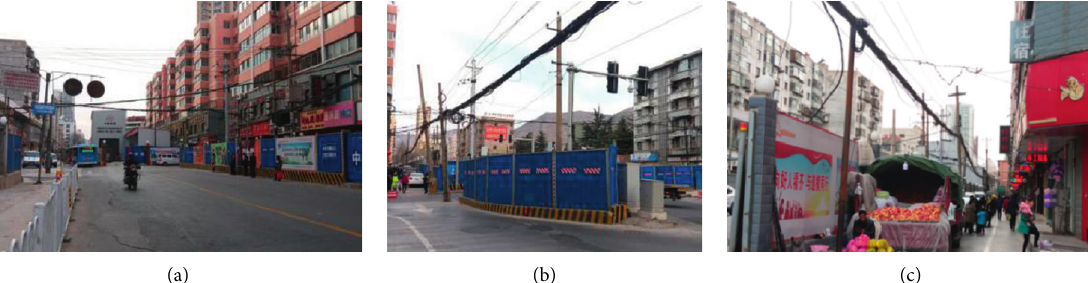
Figure 3: Power line status in construction section. (a) Communication lines. (b) Overhead status of communication lines. (c) Household